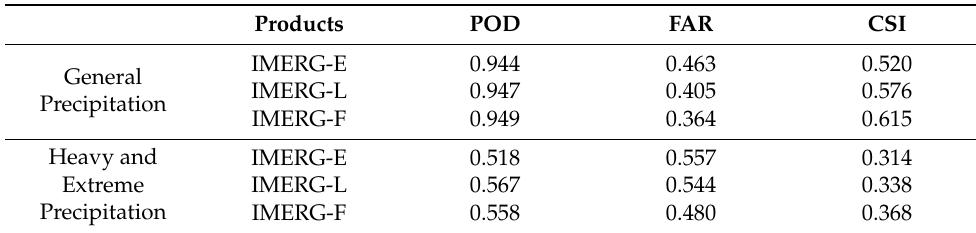
Table 4. Mean categorical verification statistics: probability of detection (POD), false alarm ratio (FAR), and critical success index (CSI) (Heavy and extreme precipitation represents daily precipitation amount greater than or equal to 20